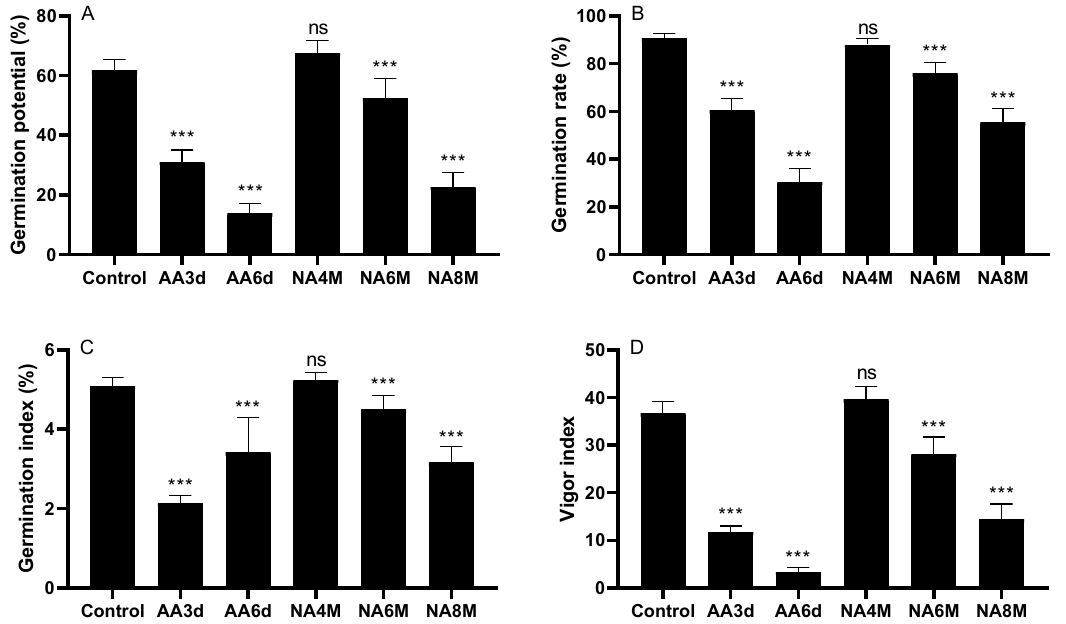
Figure 1. Estimation of seed vigor indexes of sweet corn. Values are mean ± SE. (( A ), Germination potential. ( B ), germination rate. ( C ), germination index. ( D ), vigor index). ‘ns’, *** indicate p > 0.05 and p ≤ 0.001, respectively, as compared to